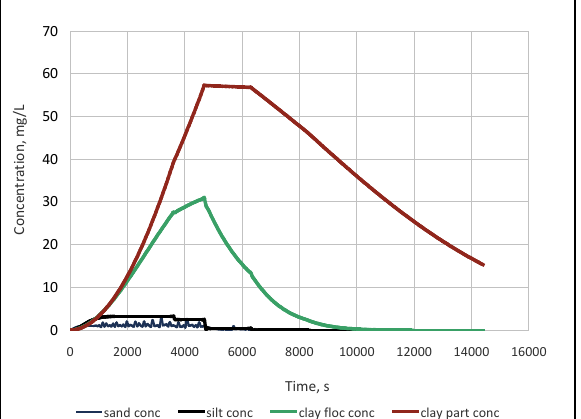
Fig. 6 Modelled re-suspension and deposition of coastal sediments in a brackish